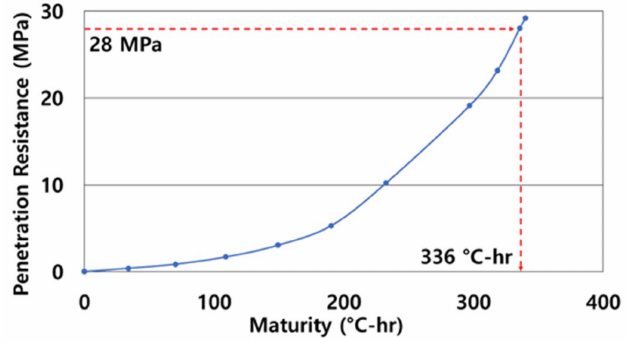
Figure 7. Maturity at final setting obtained by the mortar penetration